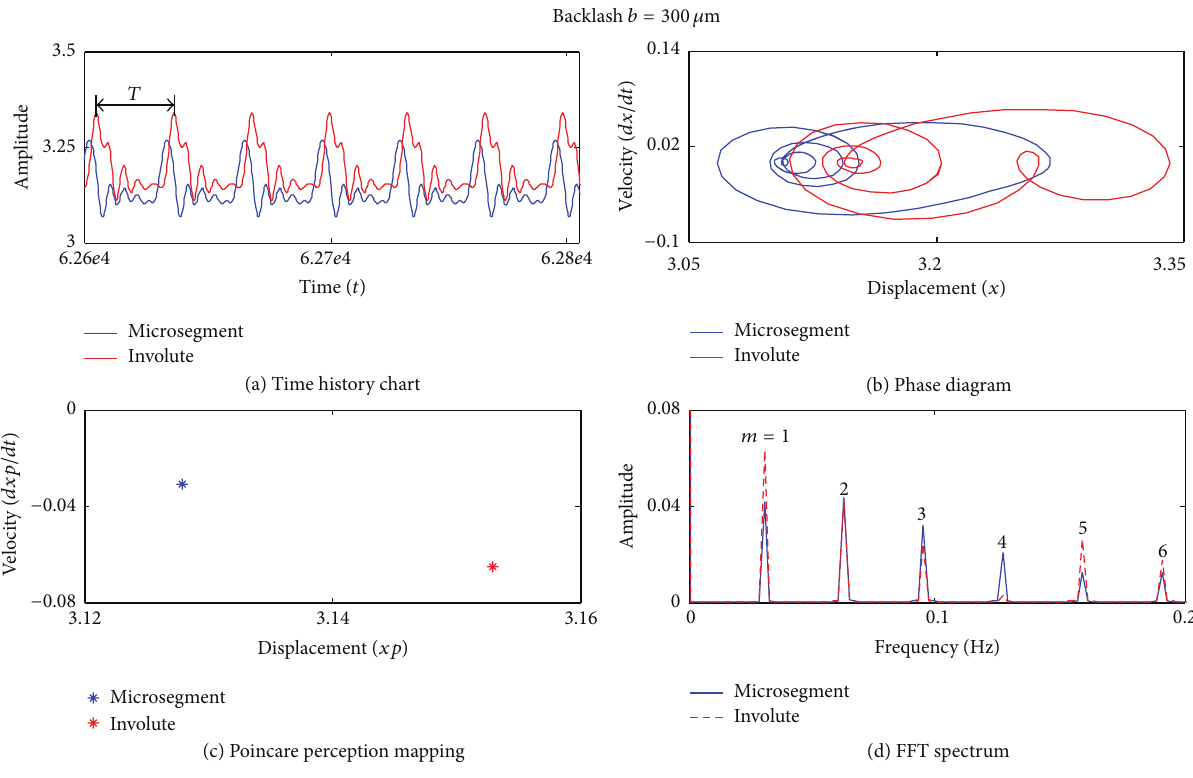
Figure 8: Dynamic performance comparison at Ω = 0.2 , 𝑇 = 200 N ⋅